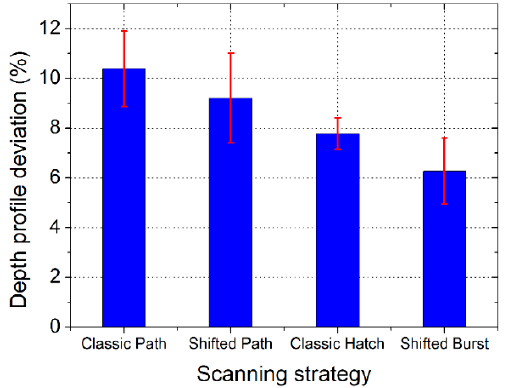
Figure 7. Measured relative deviation of the dimple depth profile for different laser texturing methods (scanning strategies) at their highest allowed scanning speeds.